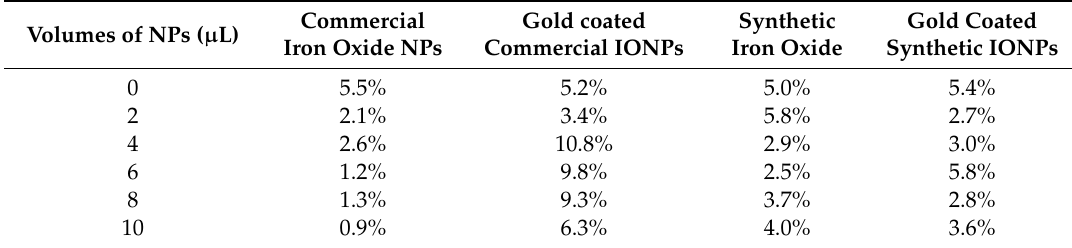
Table 5. Percentage release of CF on interaction of regular liposomes with di ff erent nanoparticles under a pulsed magnetic field.